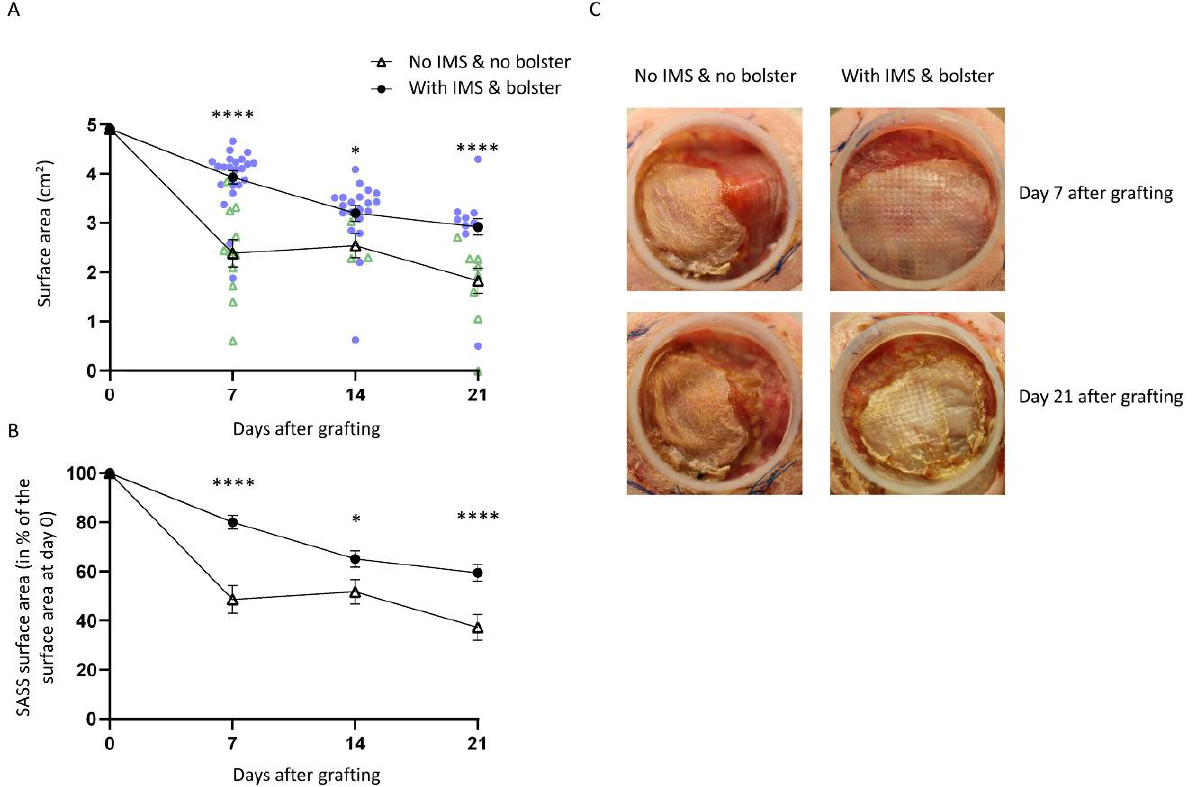
Figure 1. SASS surface area over time after grafting. ( A ) Mean surface area of SASS grafts is improved when the Fusenig’s chamber is secured with intramuscular sutures (IMS) and a bolster dressing is added over the SASS compared to only sutured to mouse skin. N = 2 to 3; n = 3 to 22. Each black point represents the mean and vertical error bars represent the standard error of the mean (SEM). Blue points represent each data point for skin substitutes grafted with IMS and bolster whereas green triangles represent each data point for skin substitutes grafted without IMS and without bolster. ( B ) Surface area of SASSs after grafting, expressed as a percentage of the SASS surface area before grafting. Each black point represents the mean and vertical error bars represent the standard error of the mean (SEM). ( C ) Representative examples of macroscopic pictures of SASSs grafted on the back of athymic mice with the conventional method (without IMS and without bolster dressing) or with IMS and a bolster. Statistical analyses were performed using Mann–Whitney’s non-parametric test. * p < 0.05; **** p <